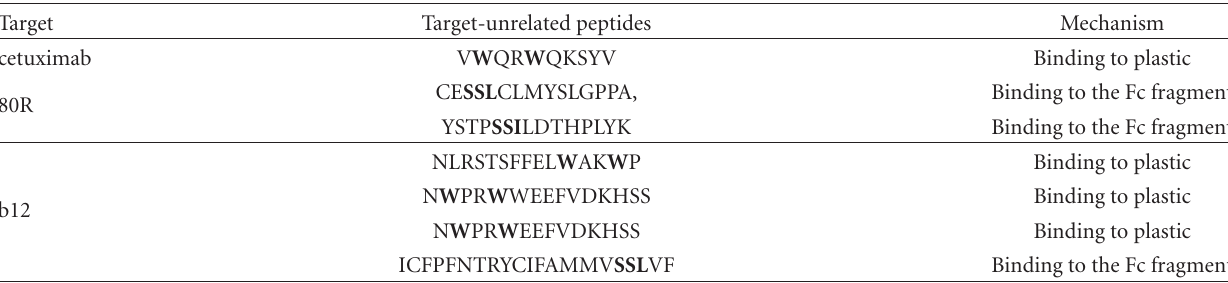
Table 3: Target-unrelated peptides in the first test data set.